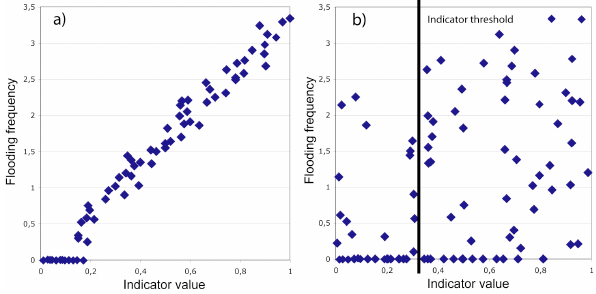
Figure 3. Relation between the flooding frequency and the indicator values in an ideal case Fig. 3. Relation between the flooding frequency and the indicator where a regression approach would be useful (a) and the actual situation (b) values in an ideal case where a regression approach would be useful (a) and the actual situation (b)